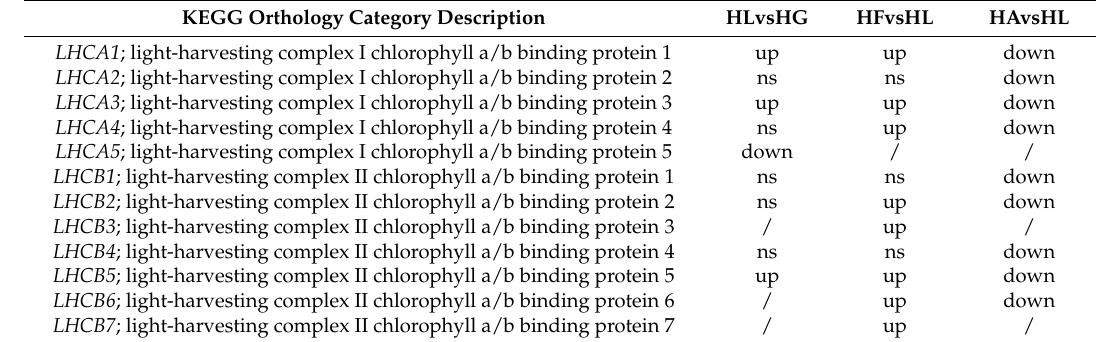
Table 6. The up-and-down regulated genes related to photosynthetic—antenna protein pathway. KEGG Orthology Category Description HLvsHG HFvsHL